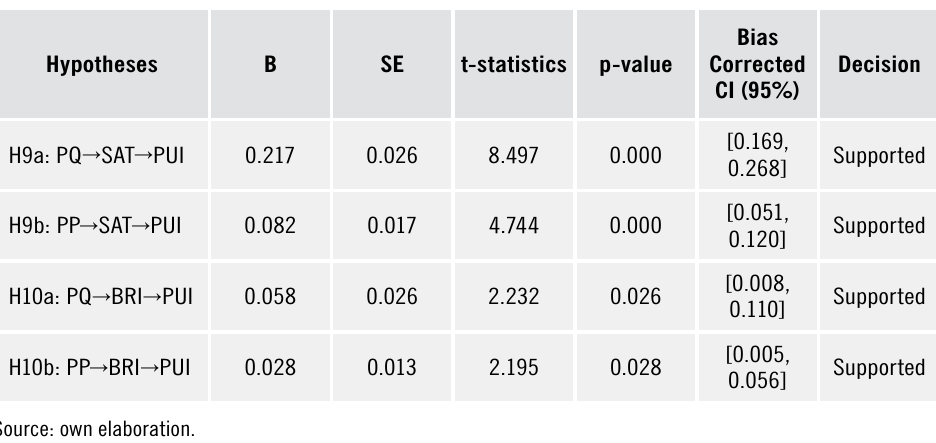
Table 7. Results of mediating effect